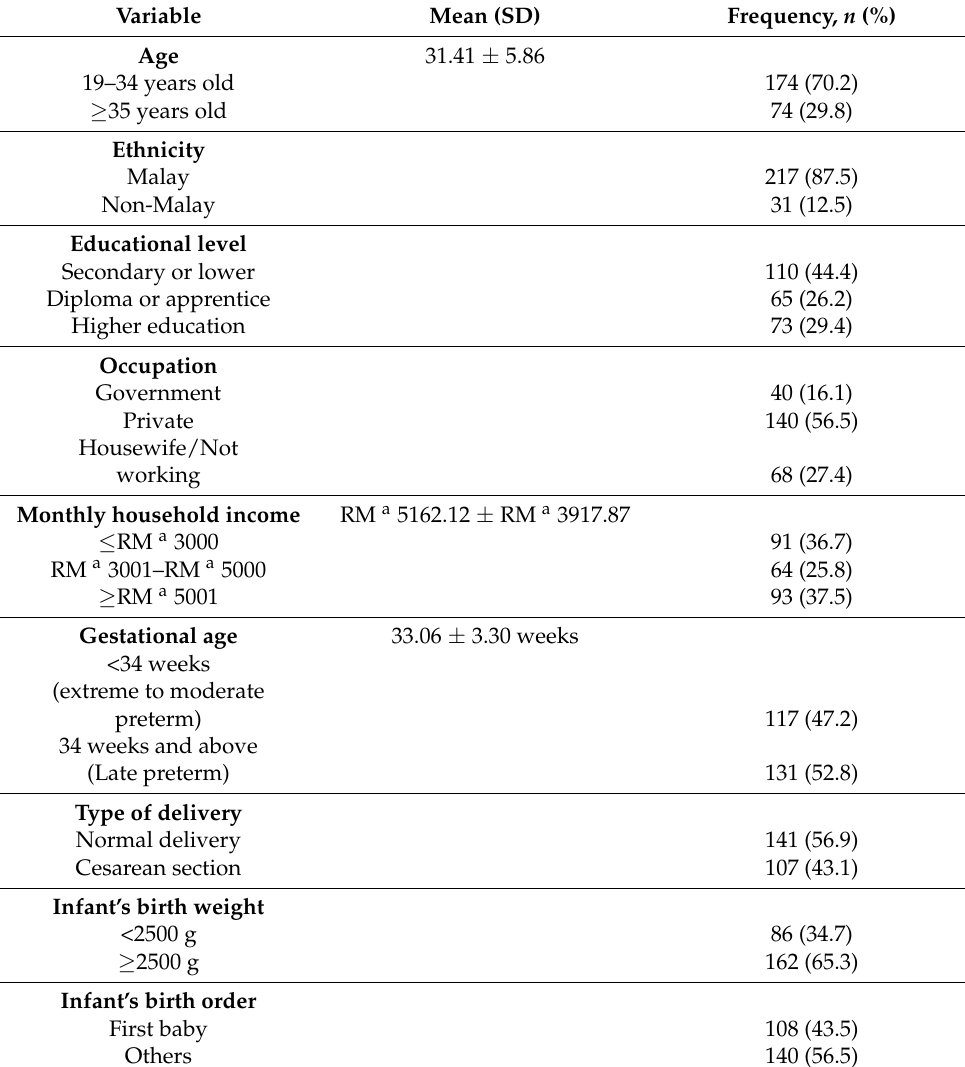
Table 1. Participant’s characteristics ( n = 248).